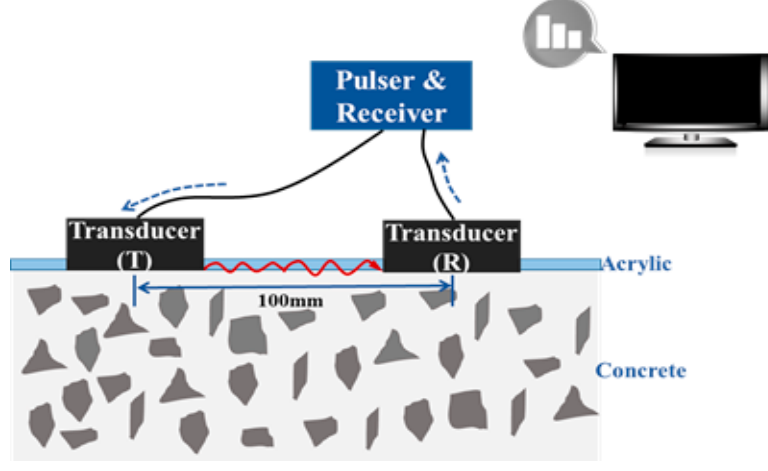
Figure 6. Schematic of the surface wave measurement setup.